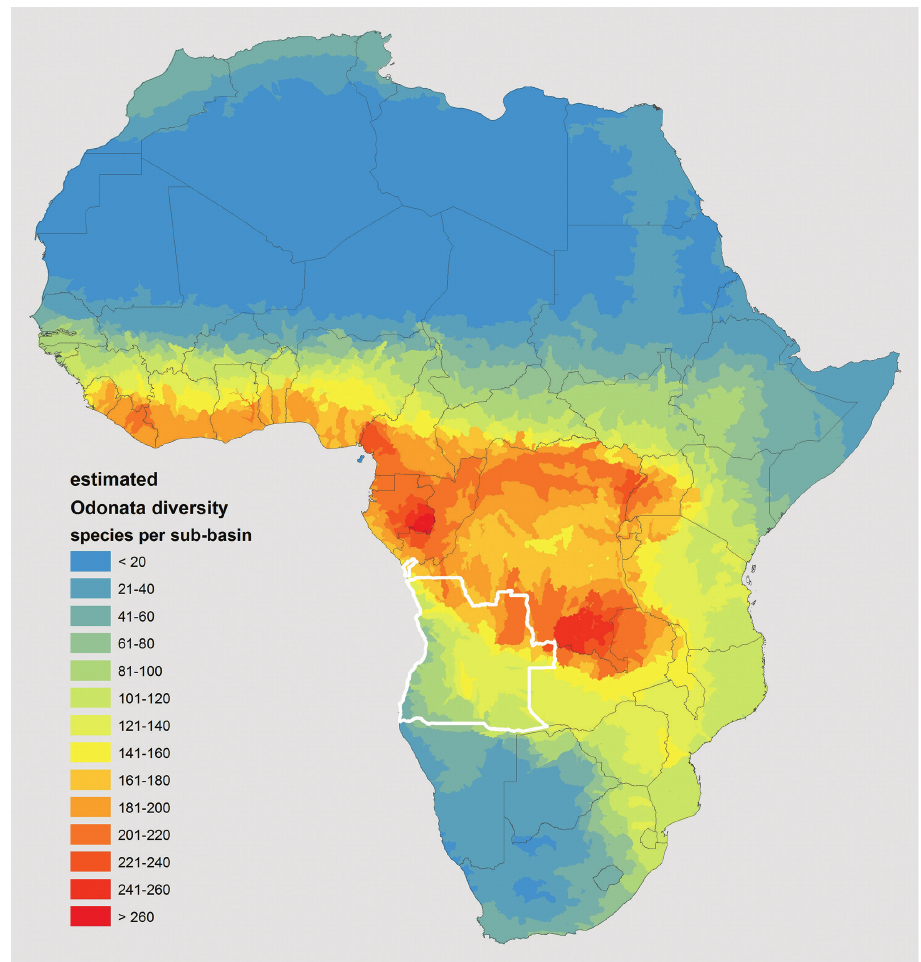
Figure 2. Distribution of Odonata diversity in continental Africa. Mapped as the number of species per Hydro1K basin (adapted from Clausnitzer et al. 2012), Angola outlined in